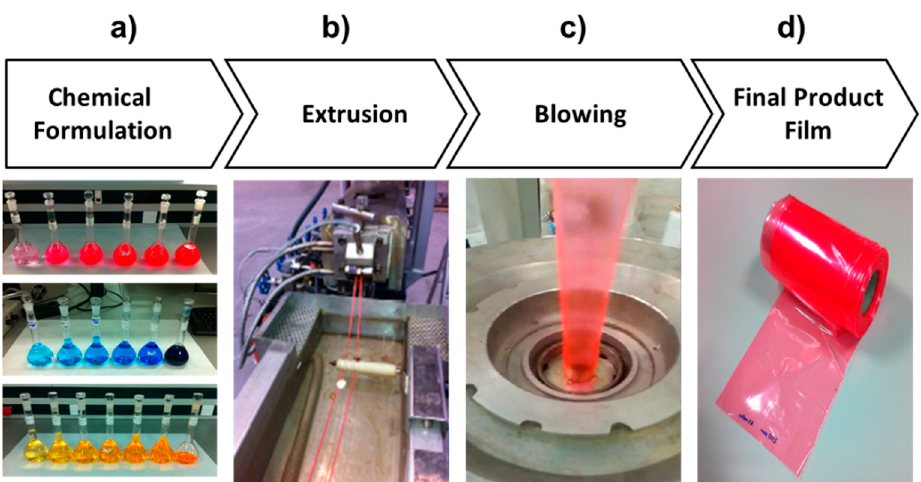
Figure 1. Manufacturing process: ( a ) chemical solutions with different dye concentrations; ( b ) ex-